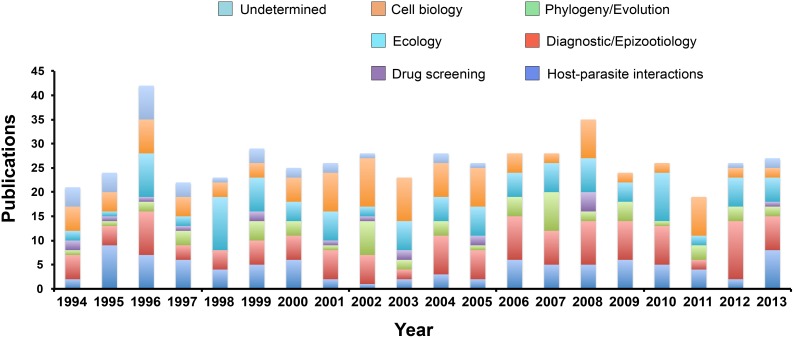
Number of papers in the literature (SCOPUS Database) reporting in the genera Perkinsus, Haplosporidium, Marteilia, and Bonamia distributed into each of the six categories; papers that did not fall into those categories were assigned to the undetermined category.